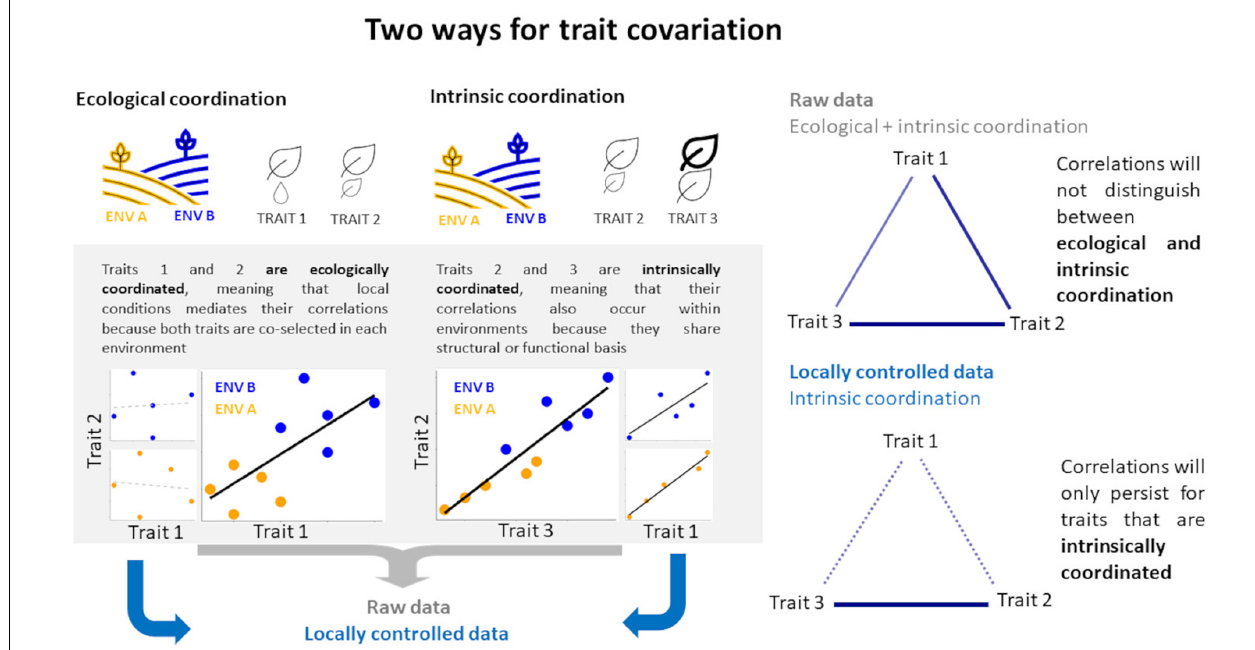
FIGURE 1 | Diagram showing two ways for trait covariation. In this hypothetical example, a single species is distributed along two local environmental conditions (ENV A = orange, ENV B = blue) and three traits are measured (Trait 1, Trait 2, and Trait 3) along the gradients in ENV A and ENV B. Correlations among traits occur for Trait 1 vs. Trait 2 and for Trait 2 vs. Trait 3 when data from both environmental conditions are pooled together (large plots, left-hand side). However, correlations may be stronger, weaker, or non-existent when the effect of environment is controlled (small plots, left-hand side). Therefore, we will only be able to discriminate between ecological and intrinsic coordination when comparing correlations based on raw data with correlations based on locally controlled